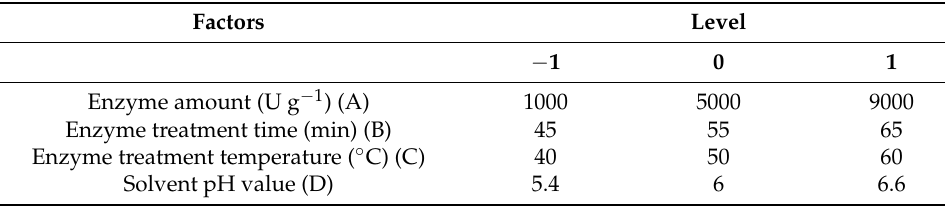
Table 1. Box–Behnken experimental